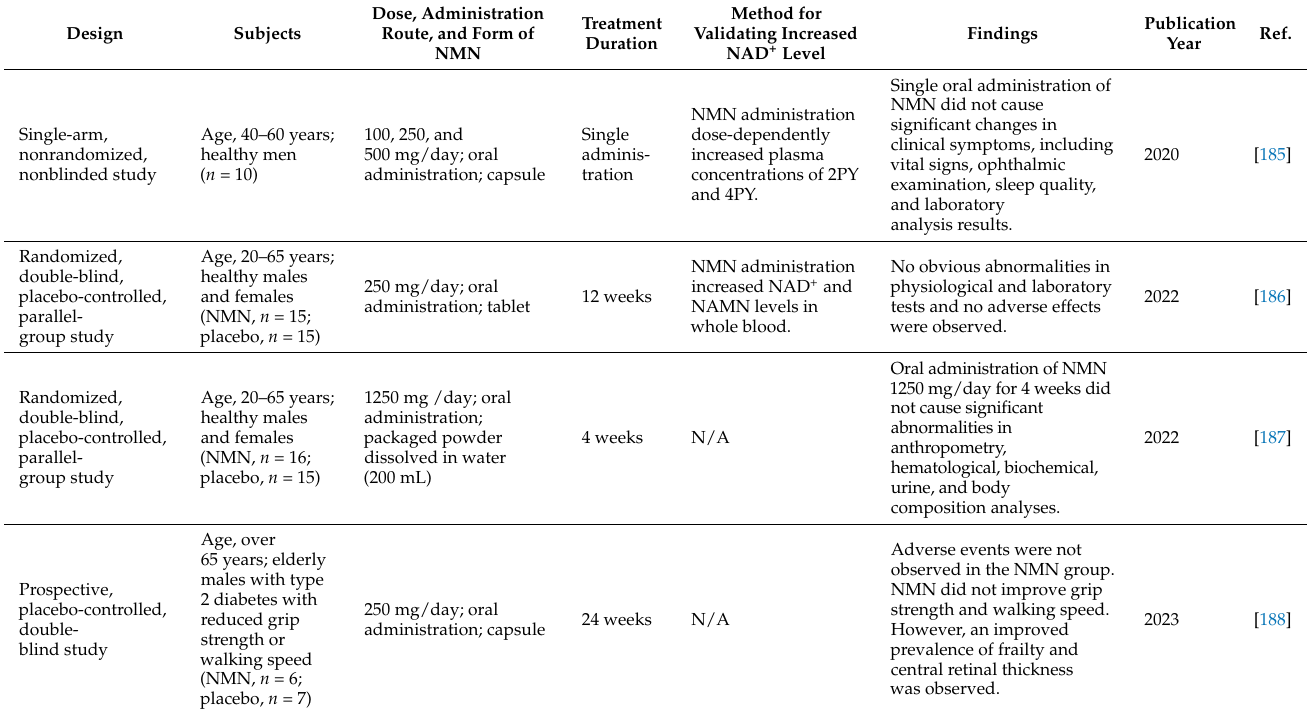
Table 1. Summary of recent NMN human clinical